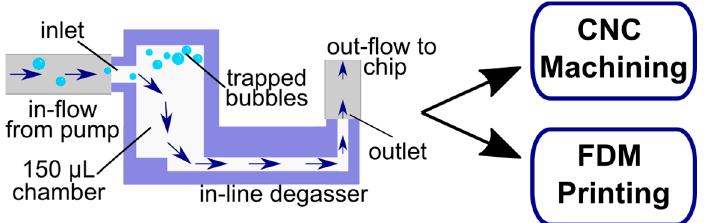
Figure 1. Schematic showing the design and principle of the passive, modular degasser, which was adapted for fabrication by CNC machining or FDM 3D printing.